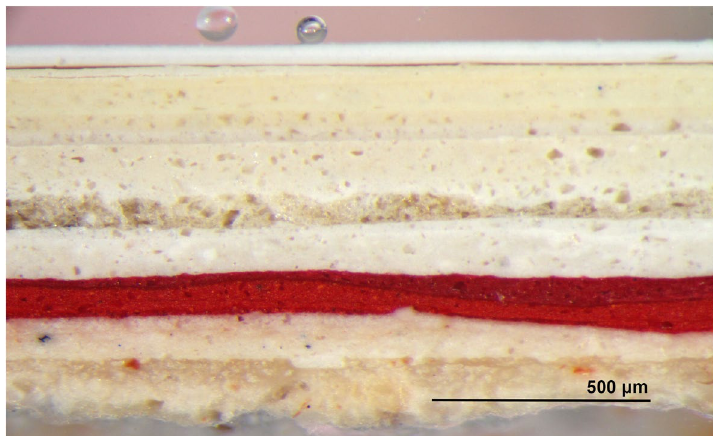
Fig. 7 Polished cross section of the paint stratigraphy: the top white finish is the currently visible paint finish; the red layer with ground and primer is the original paint layer, which was covered by several cream and white finishes at later stages. (Source: the author)